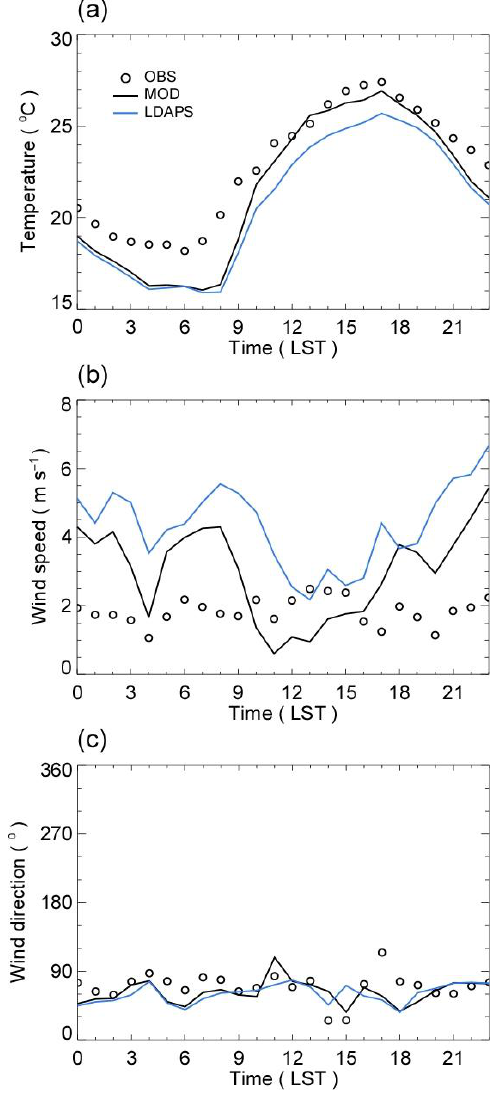
Figure 9. Comparison of the measured and simulated ( a ) air temperature, ( b ) wind speed, and ( c ) wind direction at 78 m above the ground level.